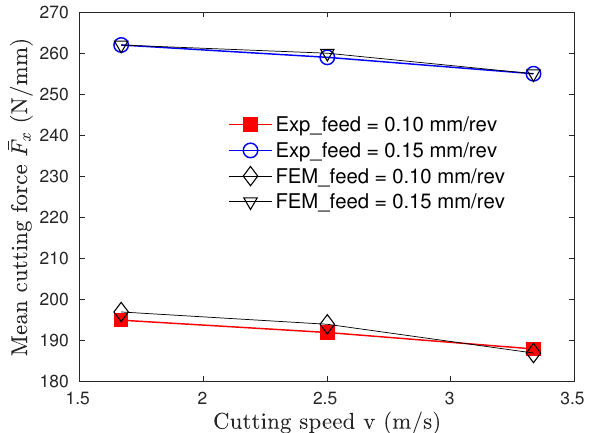
Figure 21. Mean cutting force ¯ F x vs. speed v . FEM and experimental results are shown for feed 0.10 and 0.15